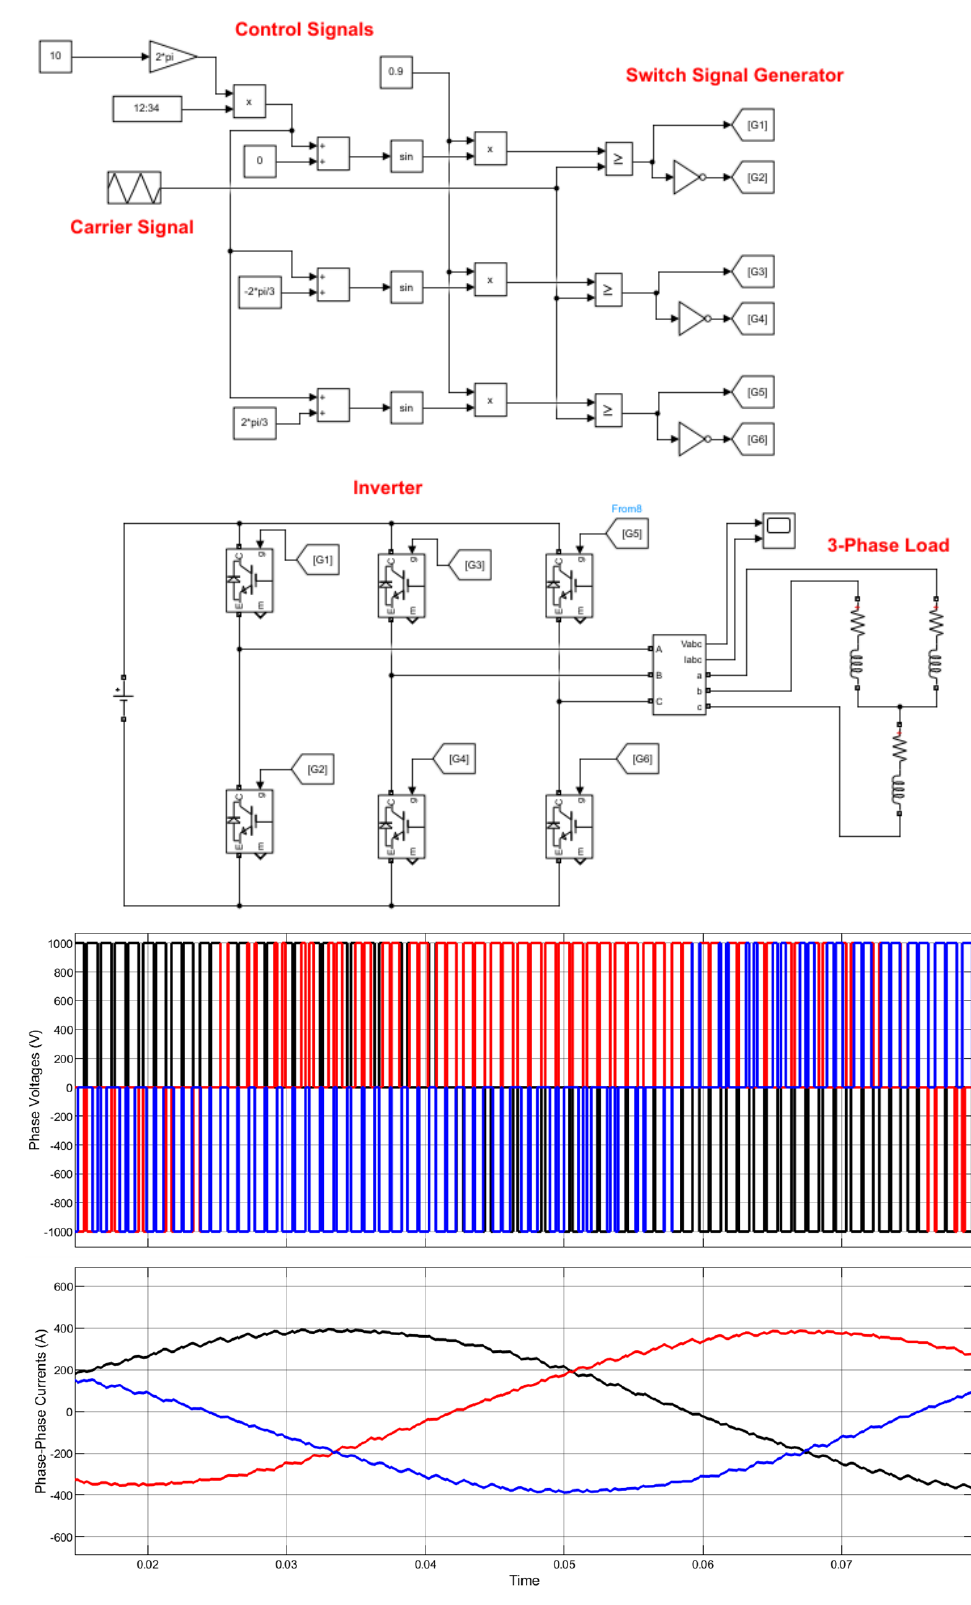
Figure 2. Typical PWM Inverter System and Output Waveforms.